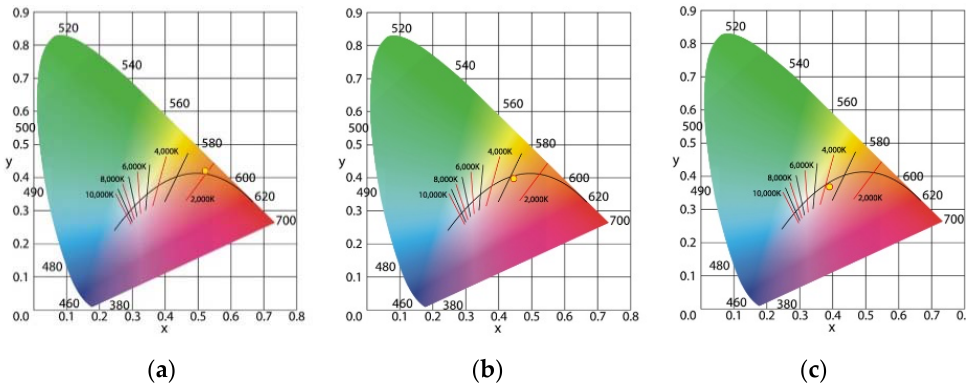
Figure 3. Colour coordinate diagram of three lighting environments. ( a ) Direct lighting CCT = 2079 K. The national museum of western art. ( b ) Indirect lighting CCT = 2960 K. The Aichi Prefectural museum of art. ( c ) Mixed lighting CCT = 3568 K. The Yamazaki Mazak museum of art.